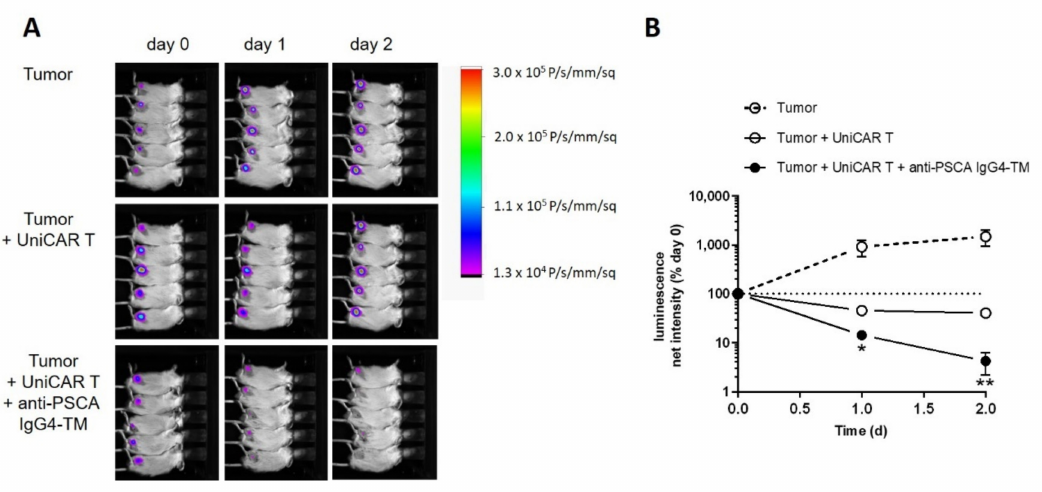
Figure 5. Evaluation of the immunotherapeutic potential of the anti-PSCA IgG4-TM in experimental mice. Immunodeficient NXG mice were subcutaneously injected with PC3-PSCA/PSMA Luc+ alone or in combination with UniCAR T cells in the absence or presence of the anti-PSCA IgG4-TM. ( A ) Luminescence images for each mouse after day 0, day 1, and day 2 are shown. ( B ) Quantitative analysis of luminescence signals. For each mouse, net intensities (P/s/mm 2 ) were normalized to net intensities measured at day 0. Mean luminescence net intensities ± SEM for five mice per group are shown (* p < 0.05, ** p < 0.01, compared to the control group “Tumor + UniCAR T”, Student’s t